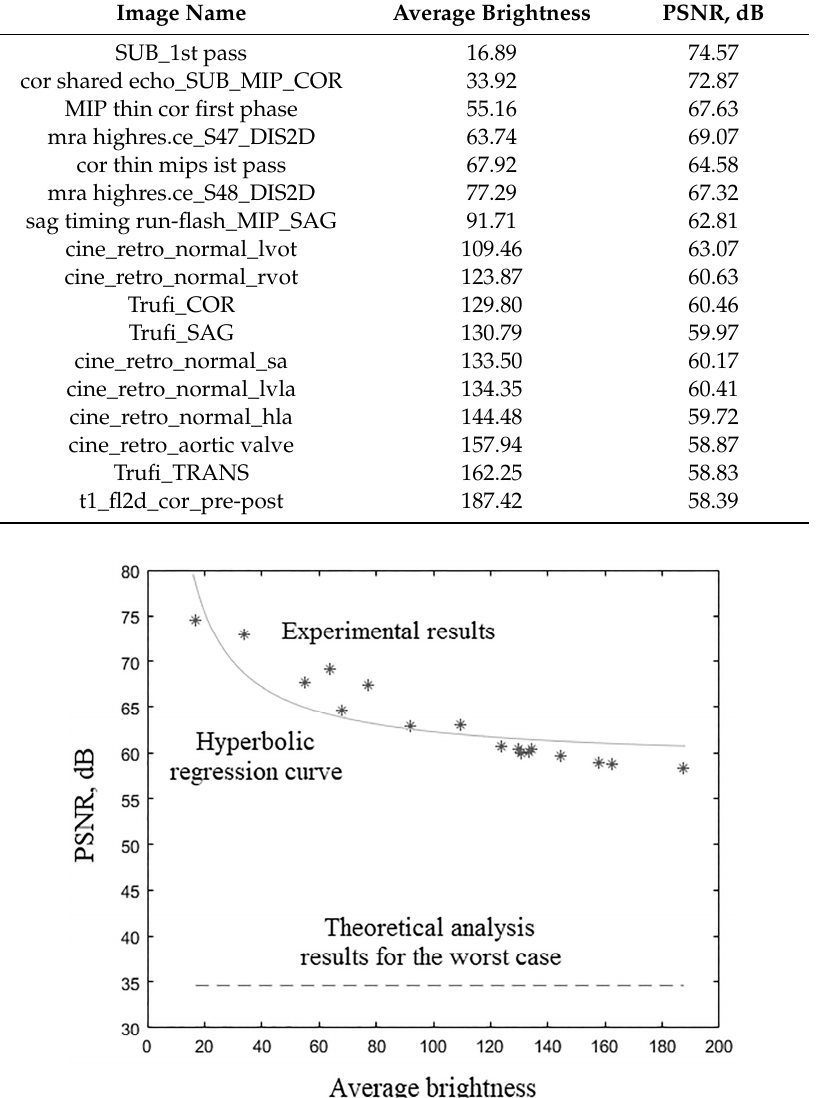
Table 34. Experimental results ( PSNR , dB) of 3D tomographic images DWT by wavelet db 4 with bit-width r = 11 of filters coe ffi cients.